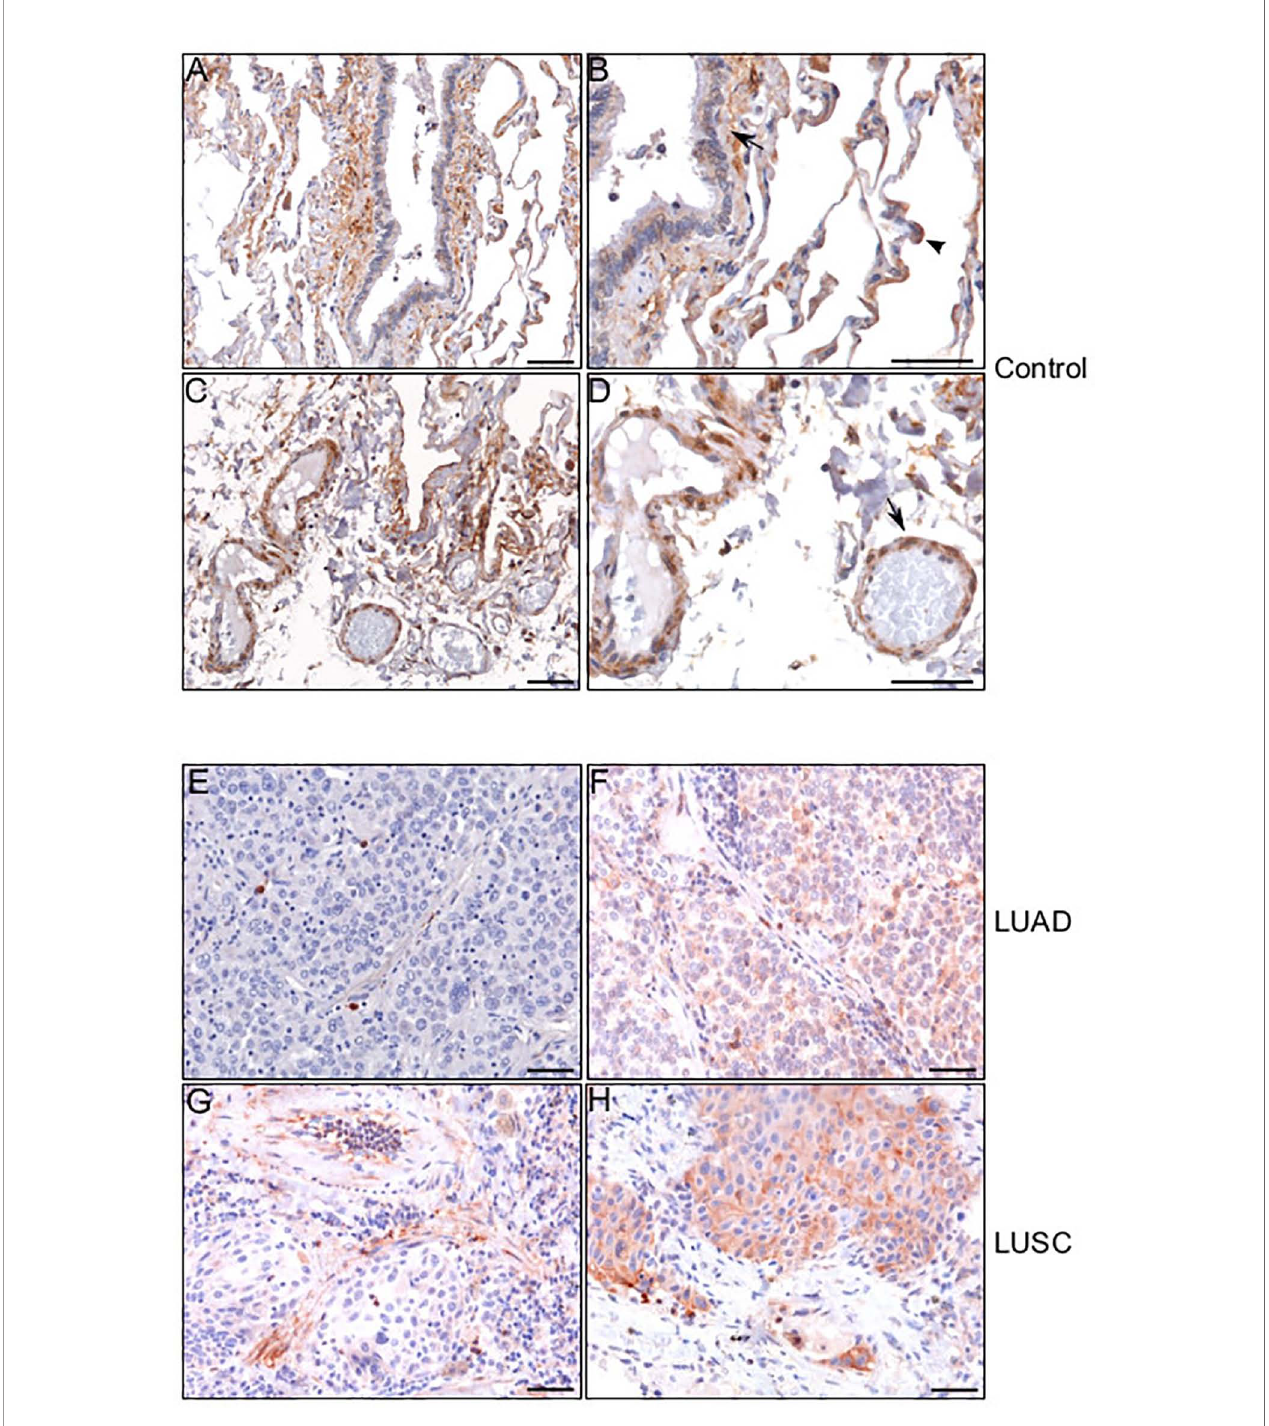
FIGURE 5 | HEPH distribution in control non-tumor lung and in LUAD and LUSC specimens. Representative microphotographs relative to HEPH distribution in non-tumor lung (A – D) . In panel (B) an HEPH expressing type II pneumocyte is indicated by arrow-head while a black arrow points to smooth muscle fi bers and bronchiolar epithelium. In panel (D) endothelial cells are indicated by an arrow. HEPH distribution by cancer cells in the context of the two histotypes. Panels (E) (LUAD) and (G) (LUSC) show the tumoral areas in which HEPH is poorly or not expressed. Panels (F) (LUAD) and (H) (LUSC) correspond to cancer nests expressing HEPH. Polymer detection system with AEC (red) chromogen; scale bars, 50